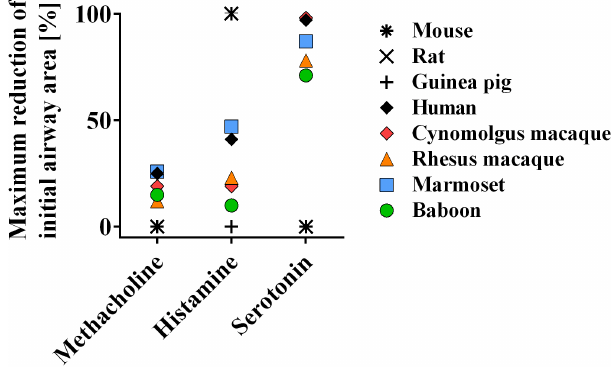
Figure 2. Nonhuman primates display bronchoconstriction similar to humans. Nonhuman primate and rodent PCLS were stimulated with methacholine, histamine, or serotonin, and the reduction of airway area was analyzed immediately. Adapted from Seehase et al.